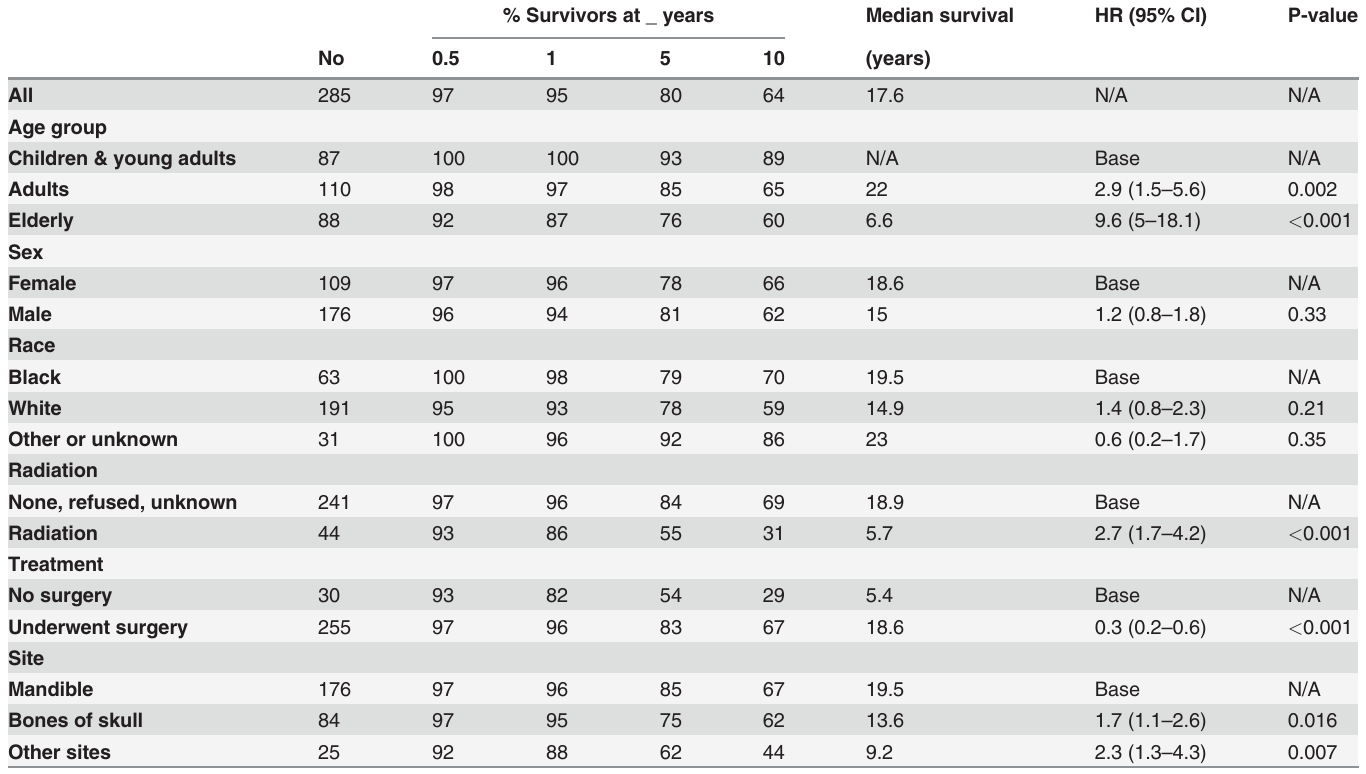
Table 3. Overall